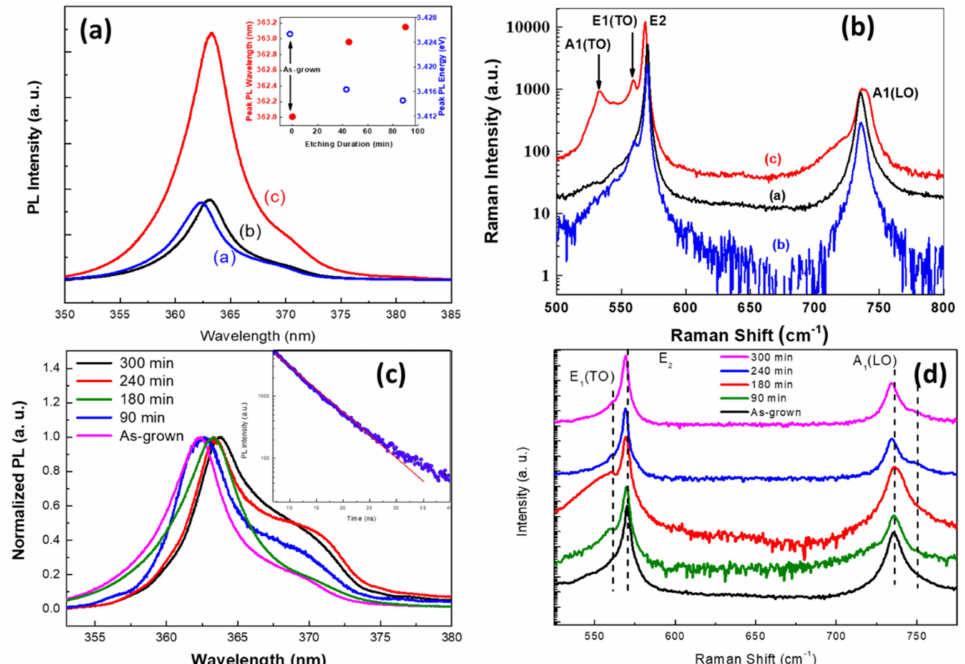
Figure 7. PL and Raman spectra of porous nanowires of GaN. We reproduced ( a , b ) from [48], with permission from Copyrights American Institute of Physics, 2012. And reproduced ( c , d ) from [46], with permission from Royal Society of Chemistry,